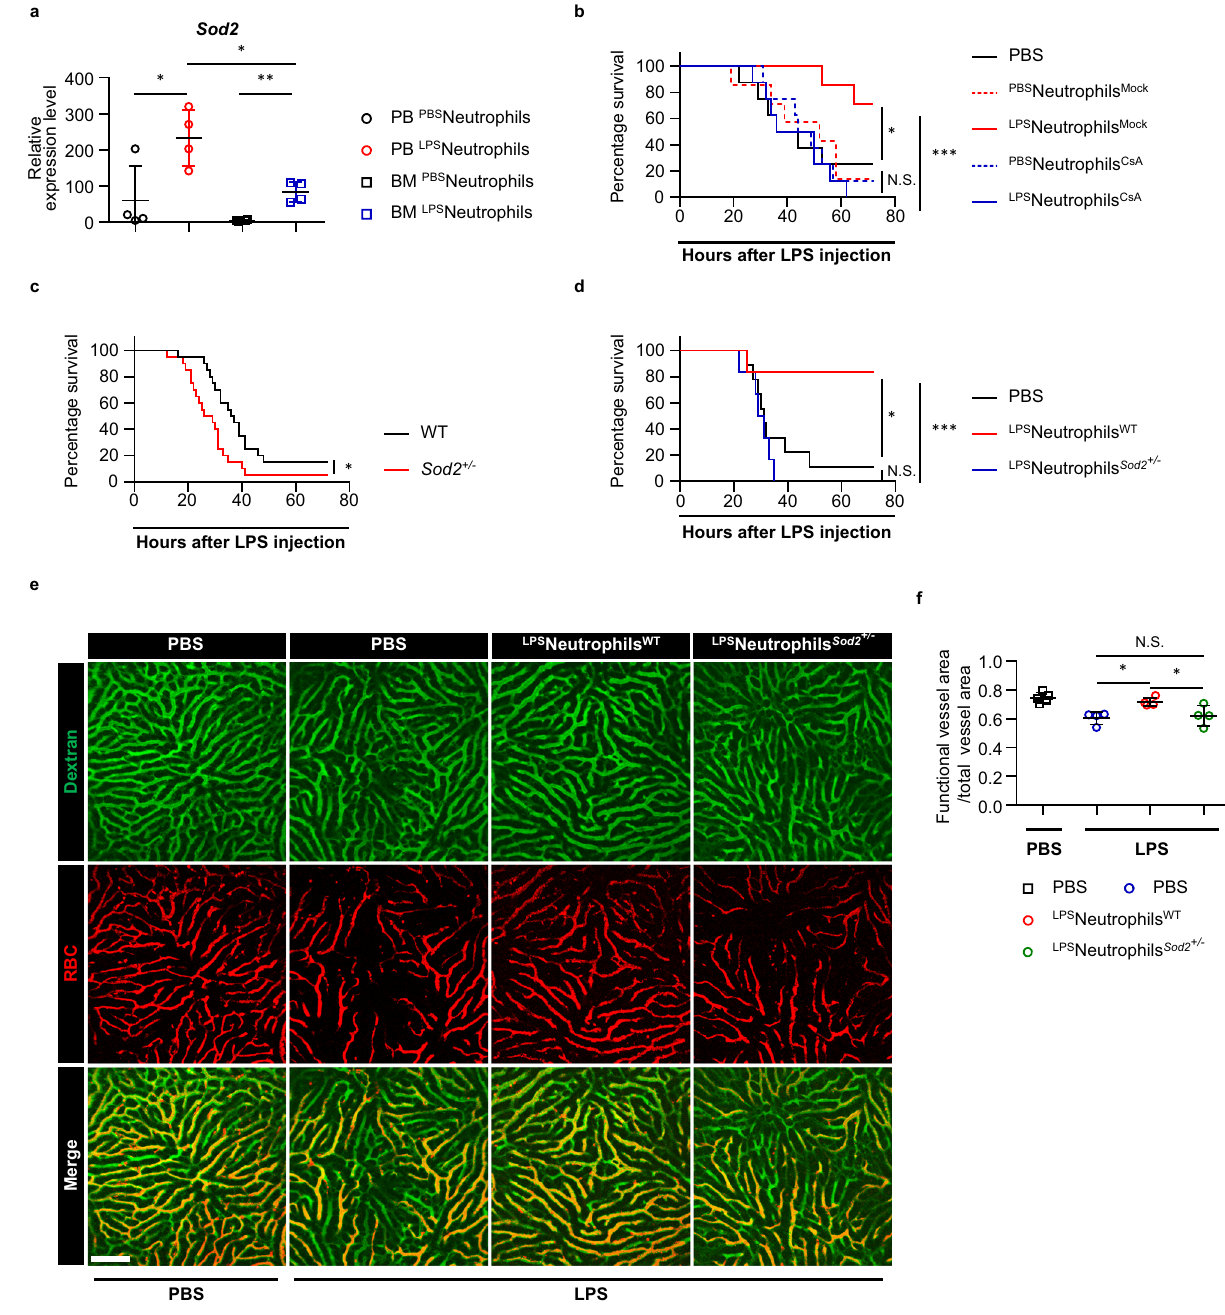
Fig. 3 | Sod2 is required for neutrophils to restrain septic DIC. a Quantitative Real-time PCR analysis of Sod2 mRNA levels in PB or BM neutrophils challenged with PBS ( PBS neutrophils) or LPS ( LPS neutrophils) ( n =4 per group). b Survival of mice after lethal LPS challenge. Mice were pre-transferred with LPS-primed PB neutrophils treated with ( LPS neutrophils Mock ) ( n =8), or without CsA ( LPS neu- trophils CsA ) ( n =7), PBS-primed PB neutrophils treated with ( PBS neutrophils Mock ) ( n =8), or without CsA ( PBS neutrophils CsA ) ( n =7) or PBS only( n =8). c Survivalcure of Sod2 +/ − mice ( n =20) and WT ( n =20) littermates after lethal LPS. p =0.0131. d Survival of mice after lethal LPS challenge. Mice were pre-transferred with LPS- primed Sod2 +/ − PB neutrophils ( LPS neutrophils Sod2+/ − ) ( n =6), LPS-primed WT PB neutrophils( LPS neutrophils WT ) ( n =6) or PBS only ( n =9). e Representative imaging